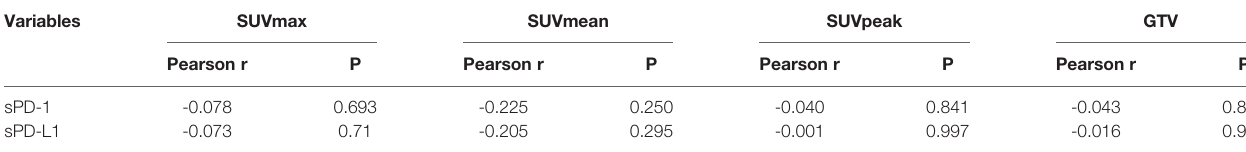
TABLE 4 | Correlations Between Uptakes of 18 F-RGD PET/CT and sPD-1/PD-L1 Expressed in Peripheral Blood of Twenty-Eight Patients. Variables SUVmax